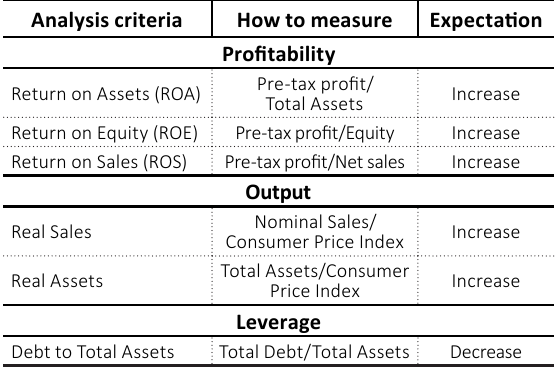
Table 1. Definition of criteria for analyzing financial